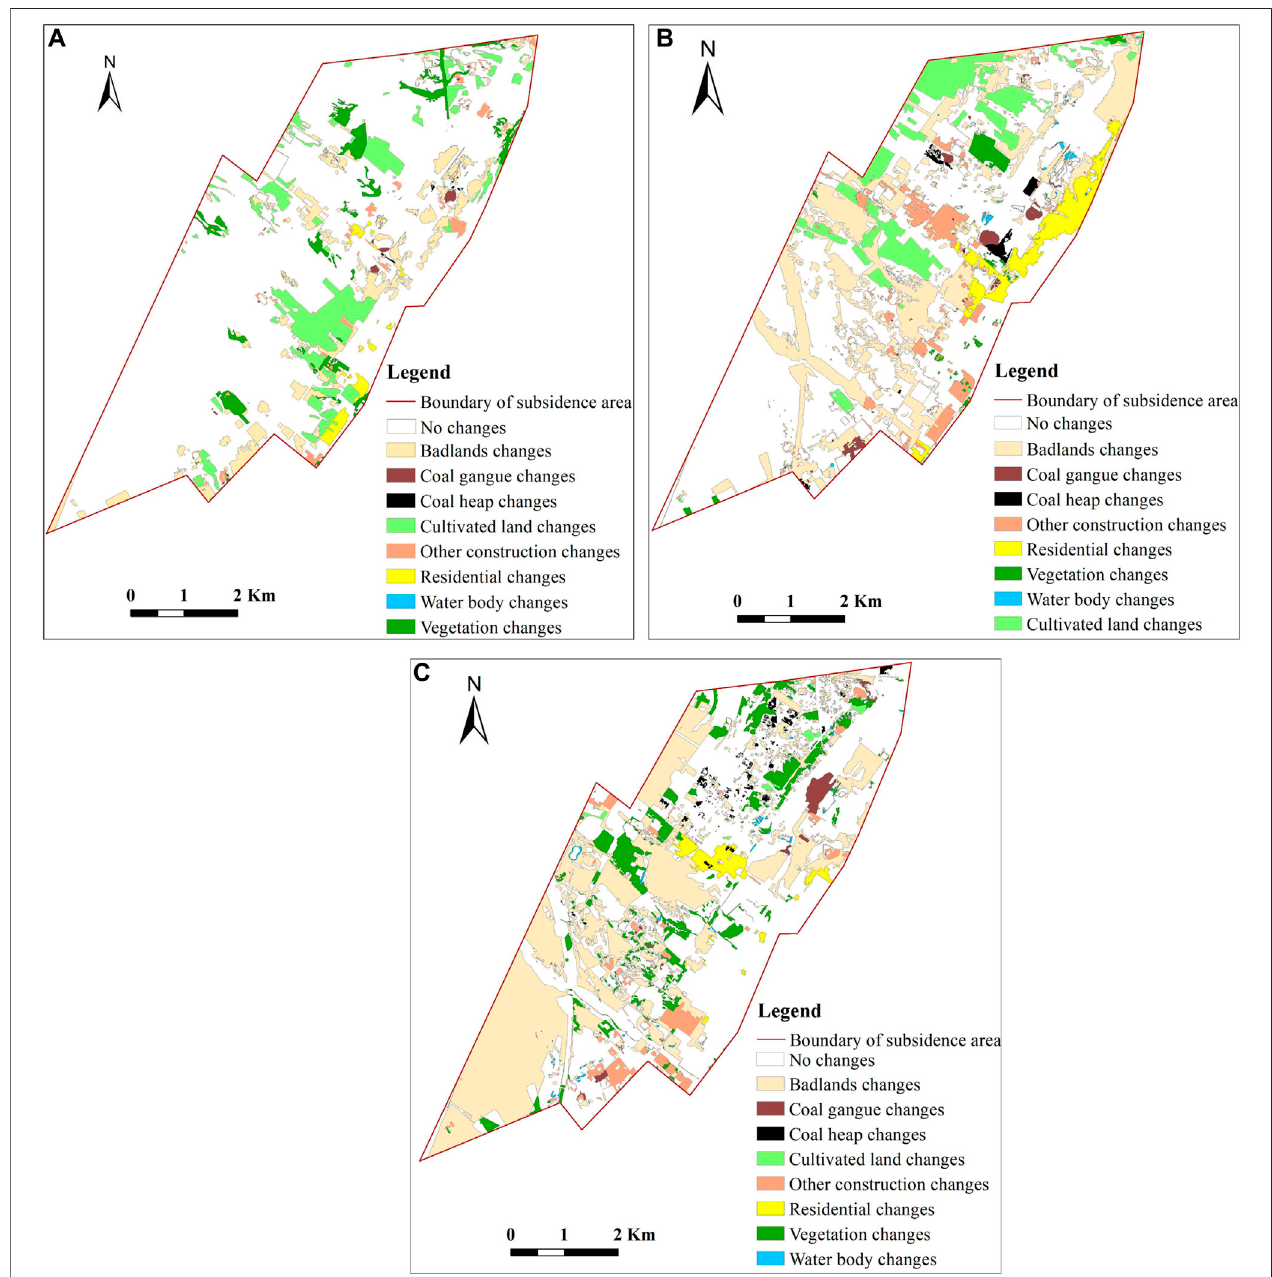
FIGURE 11 | Maps on surface environment changes in the Huinong coal mining subsidence area. (A) 1979 to 2003, (B) 2003 to 2011, and (C) 2011 to 2018.